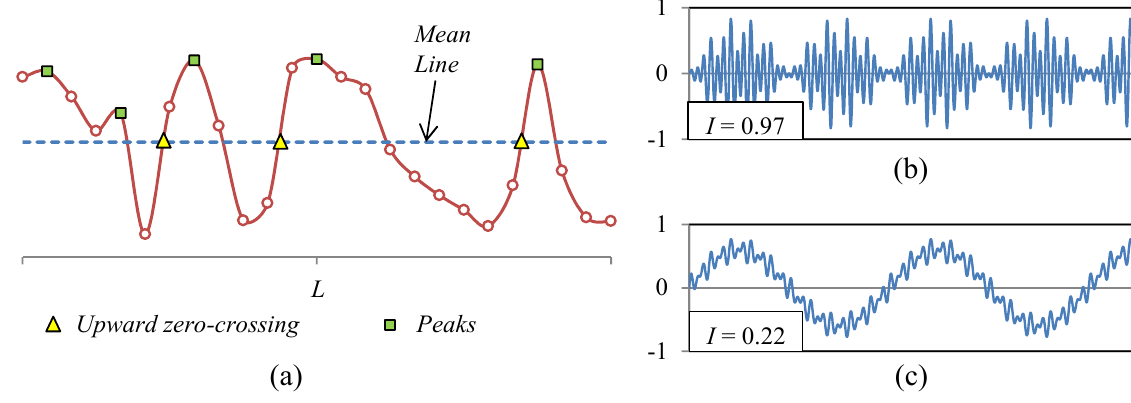
Figure 1. ( a ) Topographic profile with the theoretical points for calculating the irregularity factor; ( b ) Surface with a narrow band, I = 0.97; ( c ) Surface with a broad band, I = 0.22.